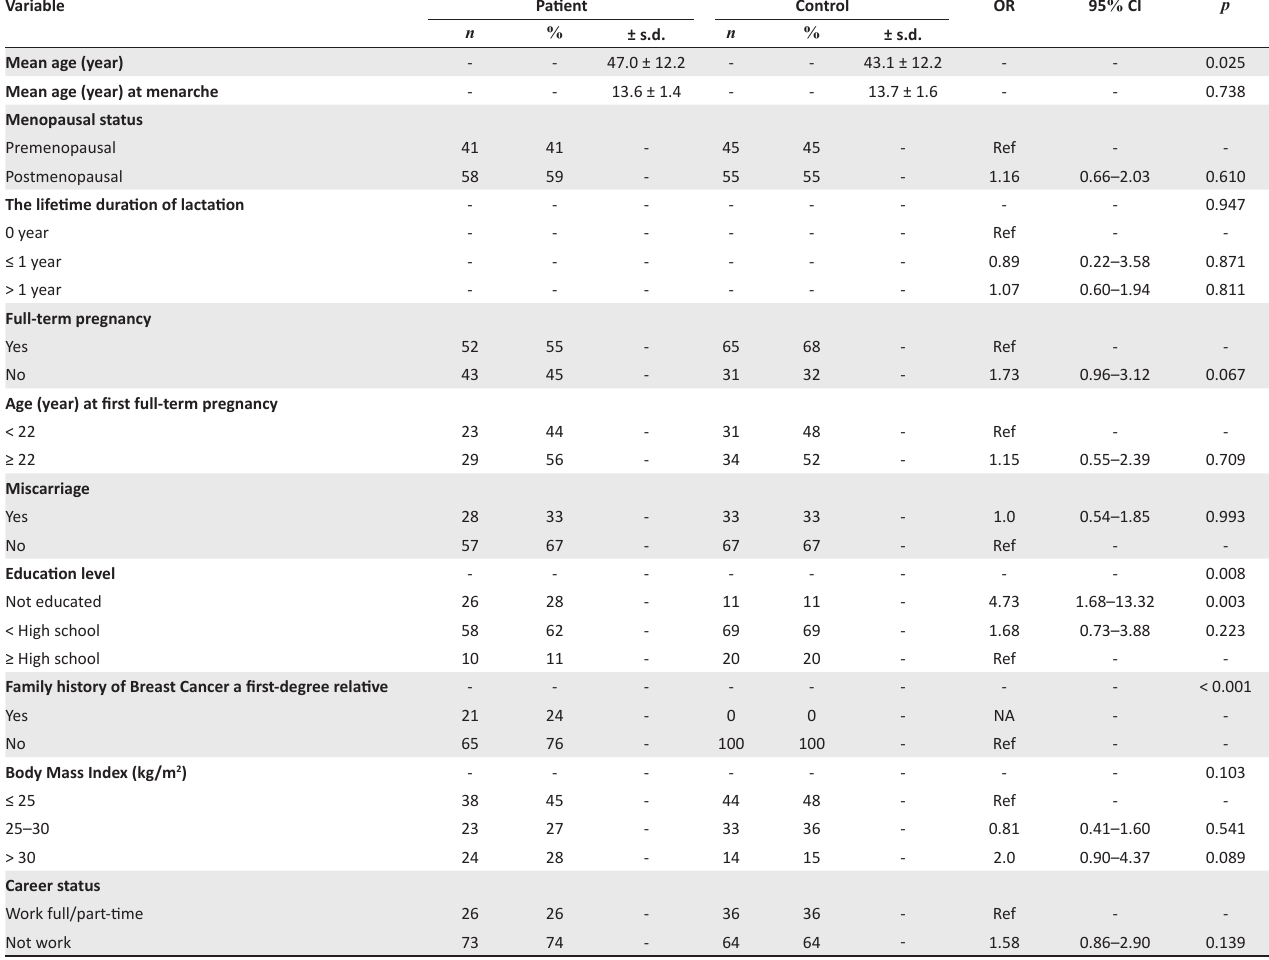
TABLE 1: Selected characteristics of breast cancer patients and the control group among Sudanese women. Variable